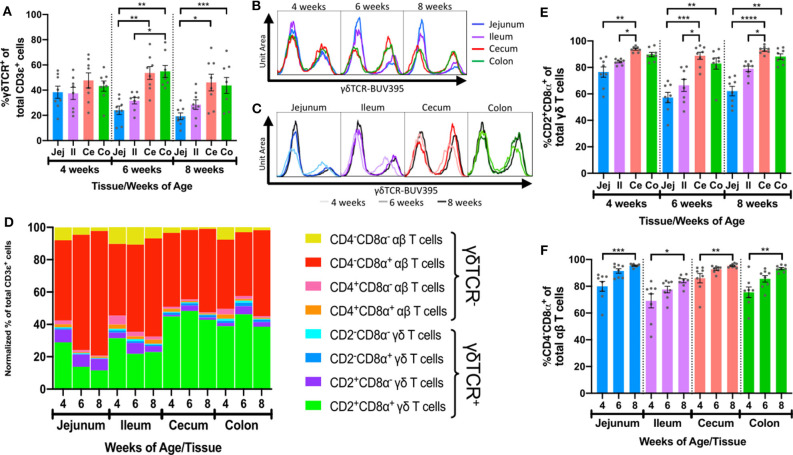
Intestinal location and age affected frequencies and phenotypes of αβ and γδ IETs. (A) Comparison of percentages of γδTCR+ cells from the total IET communities across intestinal tissues within a single timepoint. (B,C) Fluorescence intensities of γδTCR from the total IET communities. Frequency is proportional to unit area under the curve, and all samples are represented by equal total unit area under the curve. For fluorescence intensity curves (B,C), data are acquired from merging the subsetted data of 8 samples from each age/tissue combination used for t-SNE analysis. The same data are presented in B and C to show tissue-dependent (B) or age-dependent (C) changes. (D) Mean normalized frequencies of αβ and γδ IET populations across intestinal tissues and timepoints. Each IET population frequency is represented by a different color, and percentages of all IET populations within a single tissue and timepoint total 100%. (E) Comparison of percentages of CD2+CD8α+ cells from the total γδ IET communities across intestinal tissues within a single timepoint. (F) Comparison of percentages of CD4−CD8α+ cells from the total αβ IET communities across timepoints within a single intestinal tissue. In (A,E), statistical significance was determined within a single timepoint across tissues by the paired, rank-based Friedman test using all combinations of multiple comparisons within timepoint. In (F), statistical significance was determined within a single tissue across timepoints by the rank-based Kruskal-Wallis test using all combinations of multiple comparisons within a tissue. P < 0.05 were considered significant (* <0.05, ** <0.01, *** <0.001, **** <0.0001). Samples were taken from four animals per timepoint in each of two separate experiments (n = 8 per timepoint; n = 24 total).